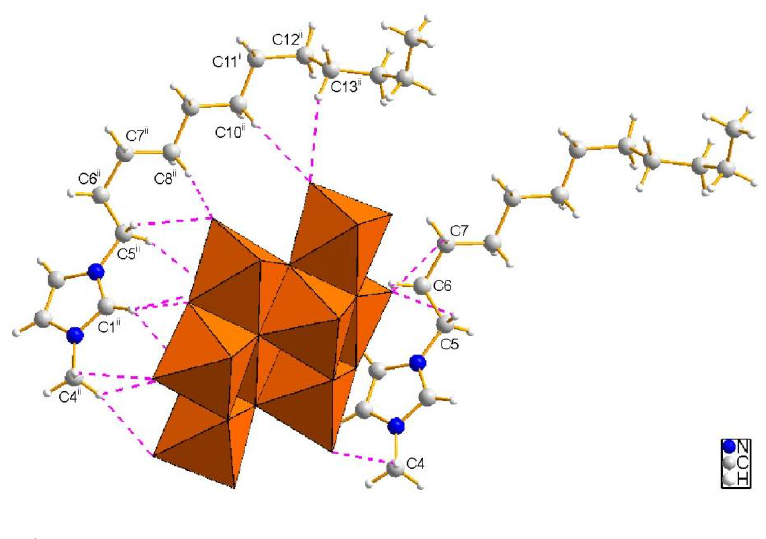
Figure 4. C–H···O hydrogen bonds in C im-Na-Mo (pink dotted line). Selected hydrogen 12 8 bonds between Mo moiety and C im are represented [symmetry code: (ii) x , −1 + y , z ]. Na + , 8 12 ethyl groups, and EtOH are omitted for